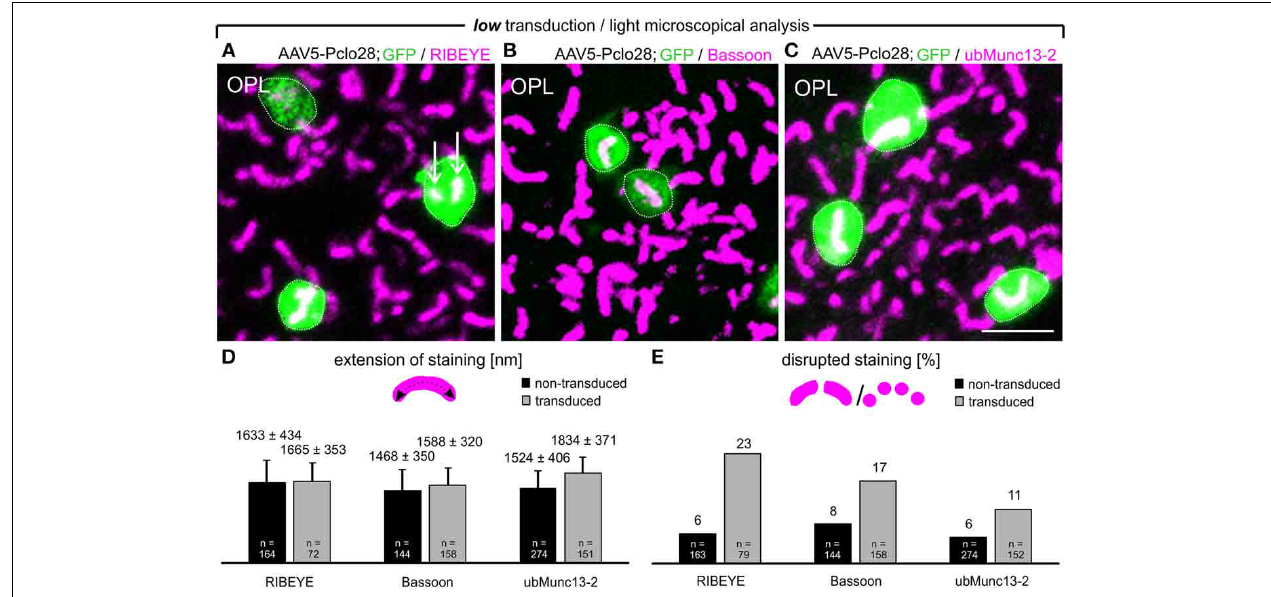
FIGURE 3 | Whole-mount preparations of AAV5-Pclo28-transduced retinae and analysis of the Piccolino-knockdown effect on RIBEYE, Bassoon, and ubMunc13-2 in rod photoreceptor terminals. (A-C) Double labeling of GFP (green) with RIBEYE (magenta; A ), Bassoon (magenta; B ), and ubMunc13-2 (magenta; C ) in AAV5-Pclo28-transduced whole-mounted retinae 8w p.i. Projections of confocal image stacks from the OPL. Arrows in (A) point to irregular RIBEYE staining. GFP positive rod